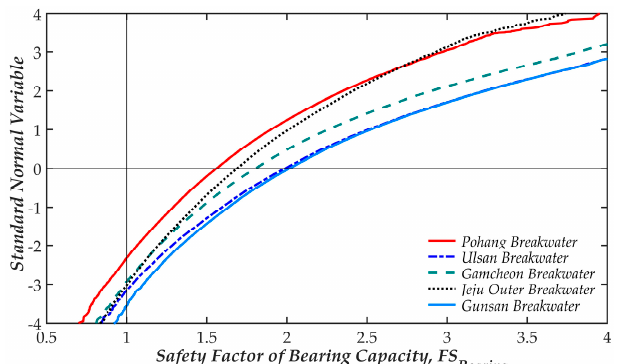
Figure 12. Cumulative density of the bearing capacity safety factor of foundation in the standard normal space.